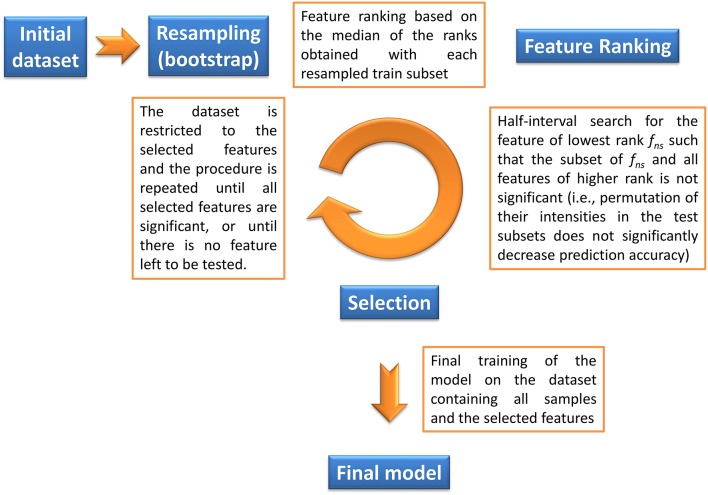
Description of the biosigner algorithm for feature selection (see Section 2 for details). The algorithm is wrapped around the PLS-DA, Random Forest, and SVM binary classifiers.